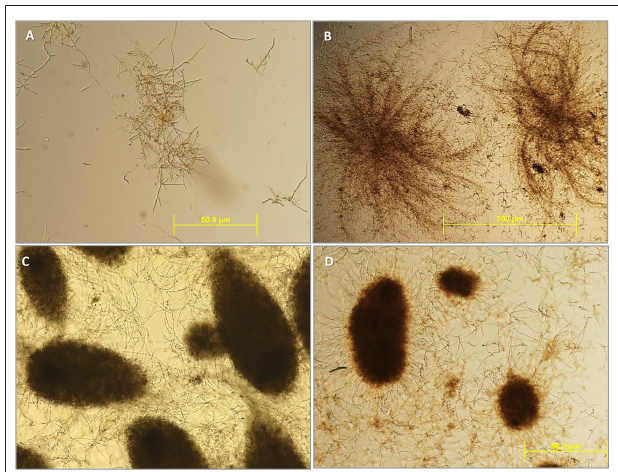
FIGURE 2 | Microsclerotia development during liquid fermentation in basal salts solution with trace metals and vitamins (C:N ratio 23:1). The initial process for the formation of microsclerotia (MS) started early in the fermentation under liquid conditions with the formation of hyphal aggregates [ (A,B) , 4 days after inoculation]. After 7 days of inoculation, the MS formed as round structures with compact pseudoparenchymatous cells layers highly melanised (C,D) . Images from: M. anisopliae A1080 (A) ; M . robertsii F447 (B) ; M. anisopliae F672 (C) ; and from M. novozelandicum F99 (D) .